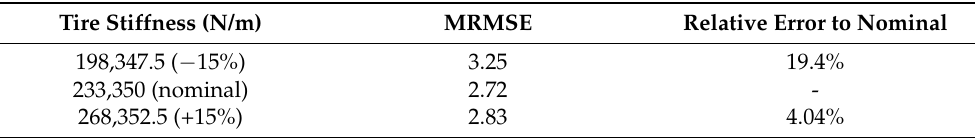
Table 3. Comparison of MRMSE for different Gaussian random noises (variances).